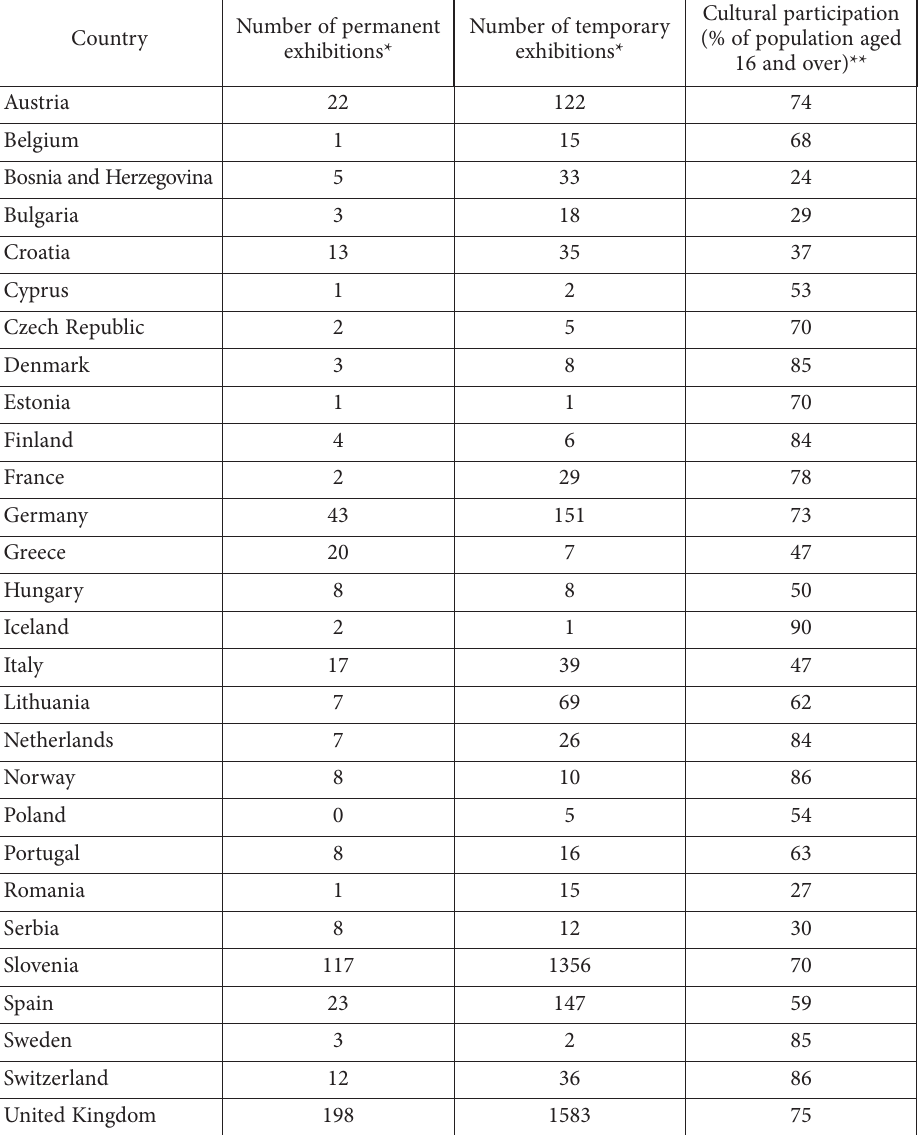
Table 1. Number of permanent and temporary exhibitions and cultural participation per country (source*: museums.eu: The European Museums Network, 2019a; Eurostat, 2018; created by authors) Number of permanent Country